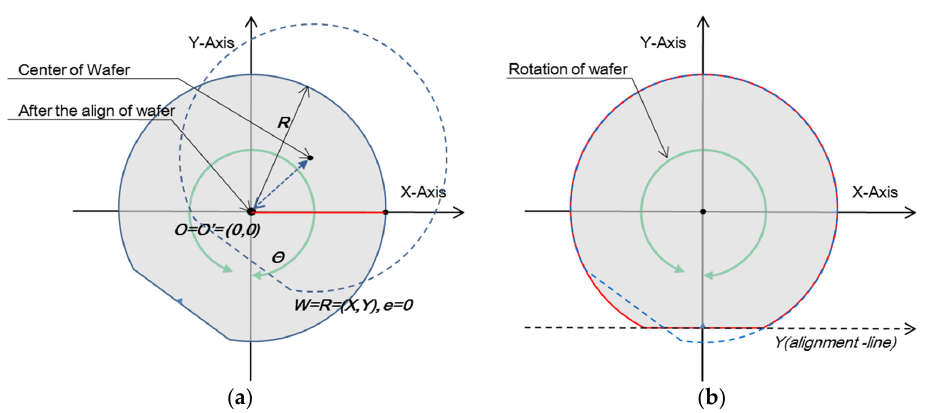
Figure 3. Wafer alignment process: ( a ) origin matching; ( b ) wafer rotation.